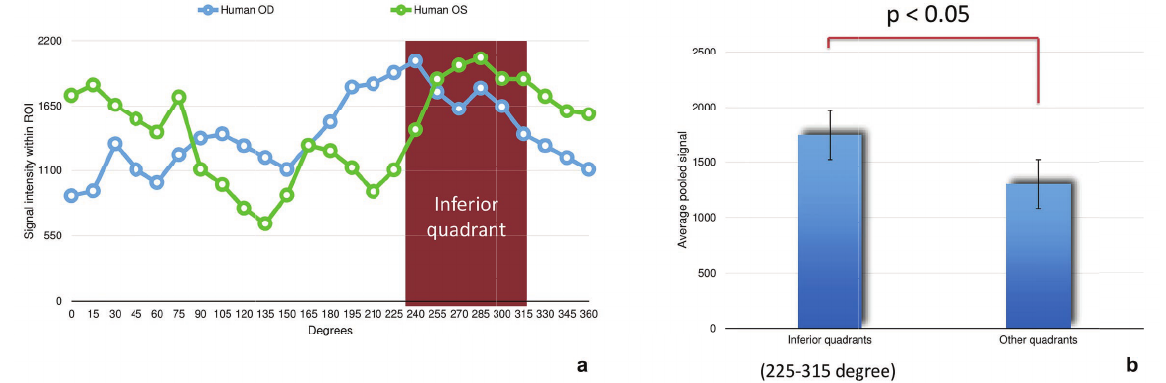
Figure 7. Fluorescent signal intensity distribution along the limbal perimeter in human eyes. (a) Signal intensity appears to concentrate more in the inferior quadrant in both human eyes. (b) The inferior quadrant has a statistically higher amount of fluorescence when compared to all other quadrants combined. Fluorescence was measured in arbitrary units (au). ROI, region of